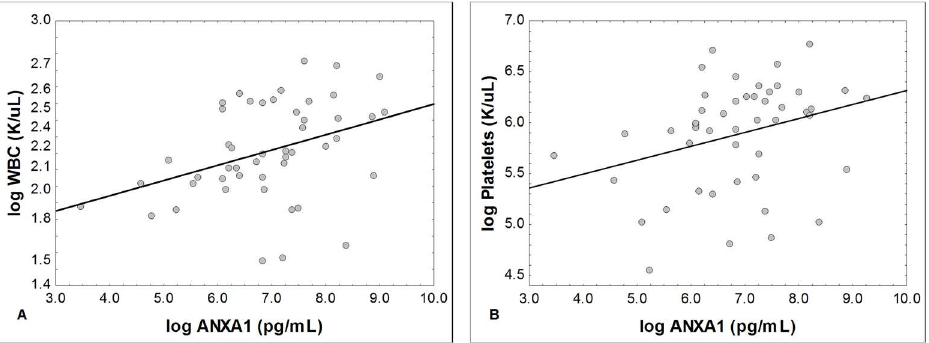
Fig 4. Correlation between plasma levels of ANXA1 and the count of WBC and platelets in SCD patients. (A) ANXA1 versus WBC. (B) ANXA1 versus Platelets. WBC: white blood cells. Statistical analysis: Pearson’s correlation. Data expressed in logarithm. Moderate correlationbetween ANXA1 and WBC: r = 0.31; p = 0.03. Moderate correlationbetween ANXA1 and platelets: r = 0.42; p =